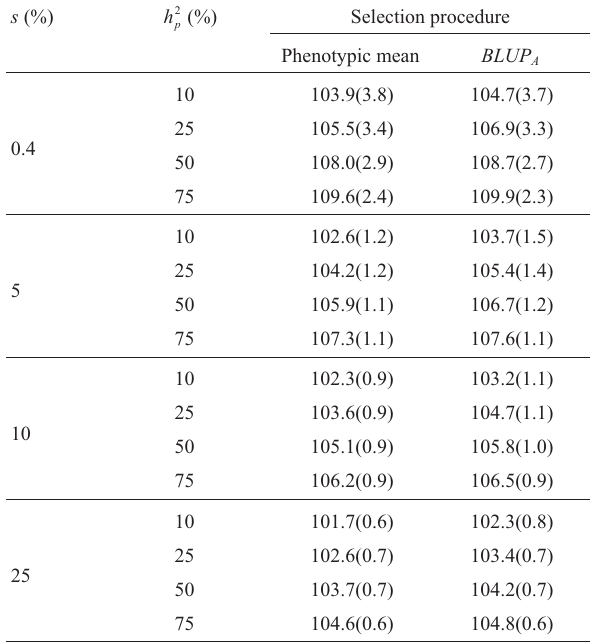
Table 4 - Mean genotypic values and standard errors (values in brackets) in the selection proportions (s) of 0.4% (best progeny), 5%, 10% and 25% of the superior F 4:5 progenies, conducted by the pedigree method, ranked by the phenotypic means ( M ) and BLUP considering the additive parent- age ( BLUP A ) for different values of heritability on a F 4:5 progeny mean ba- sis ( )